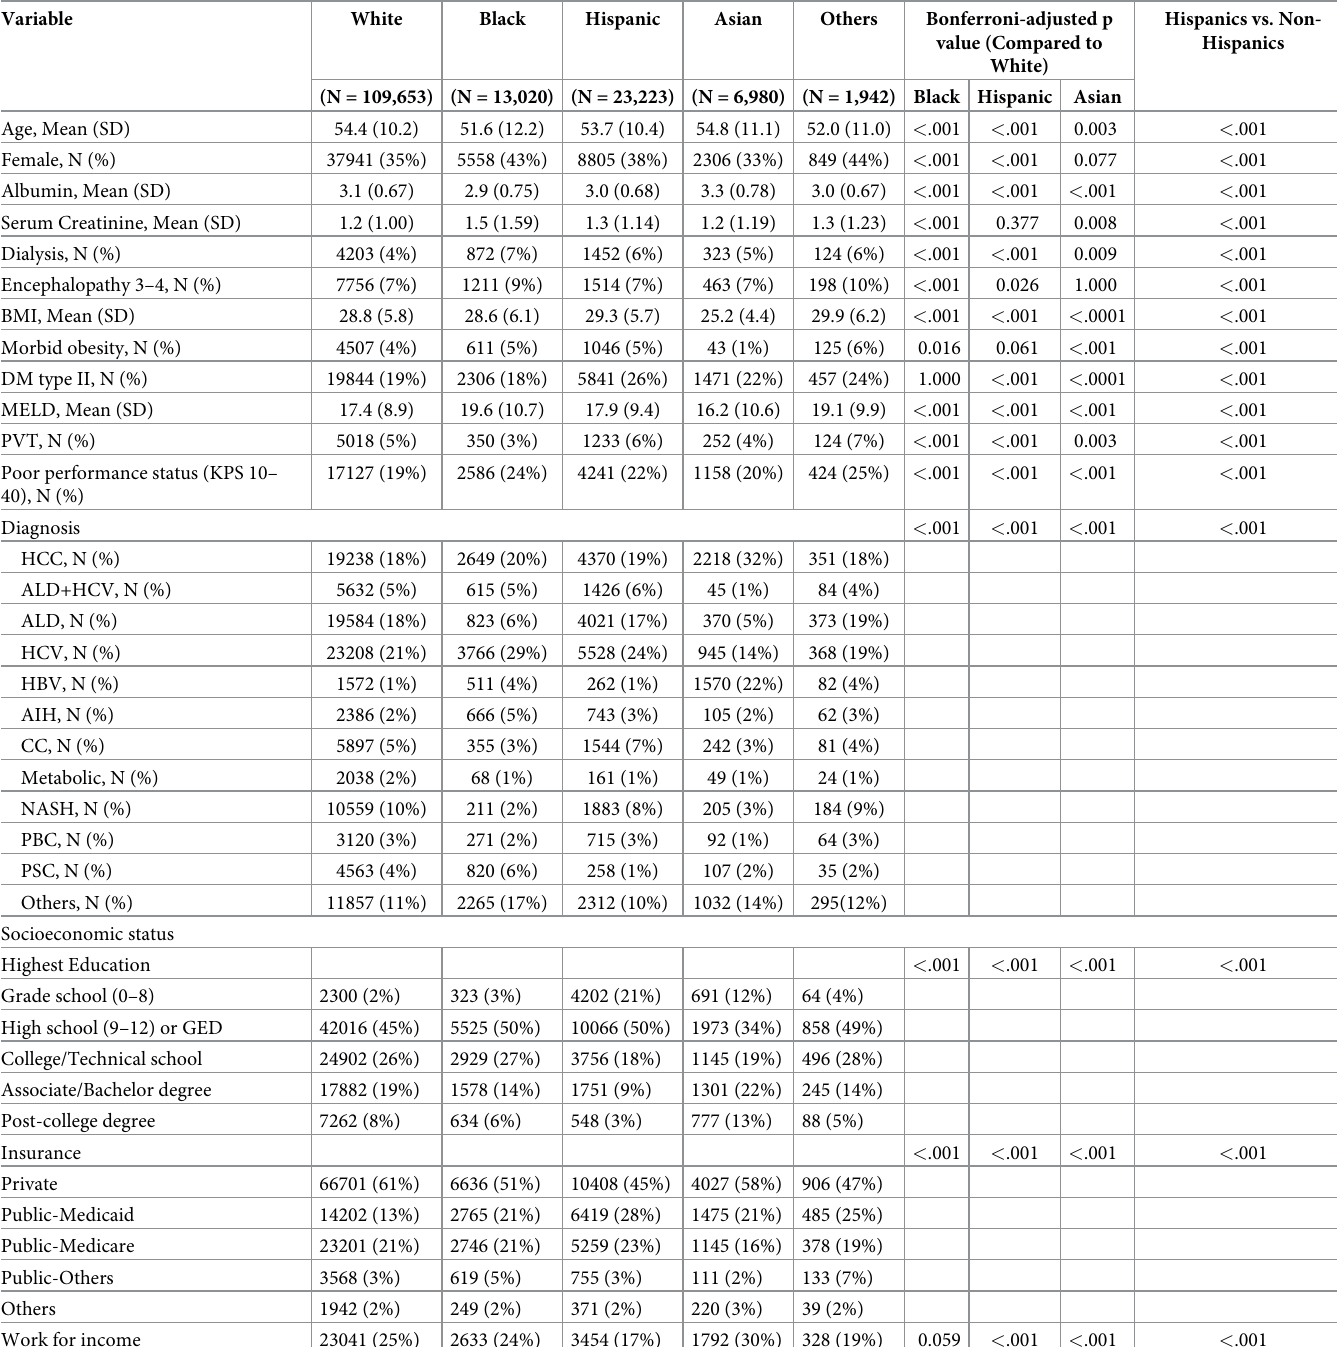
Table 1. Patients’ characteristics and pairwise comparison with Bonferroni-adjusted p